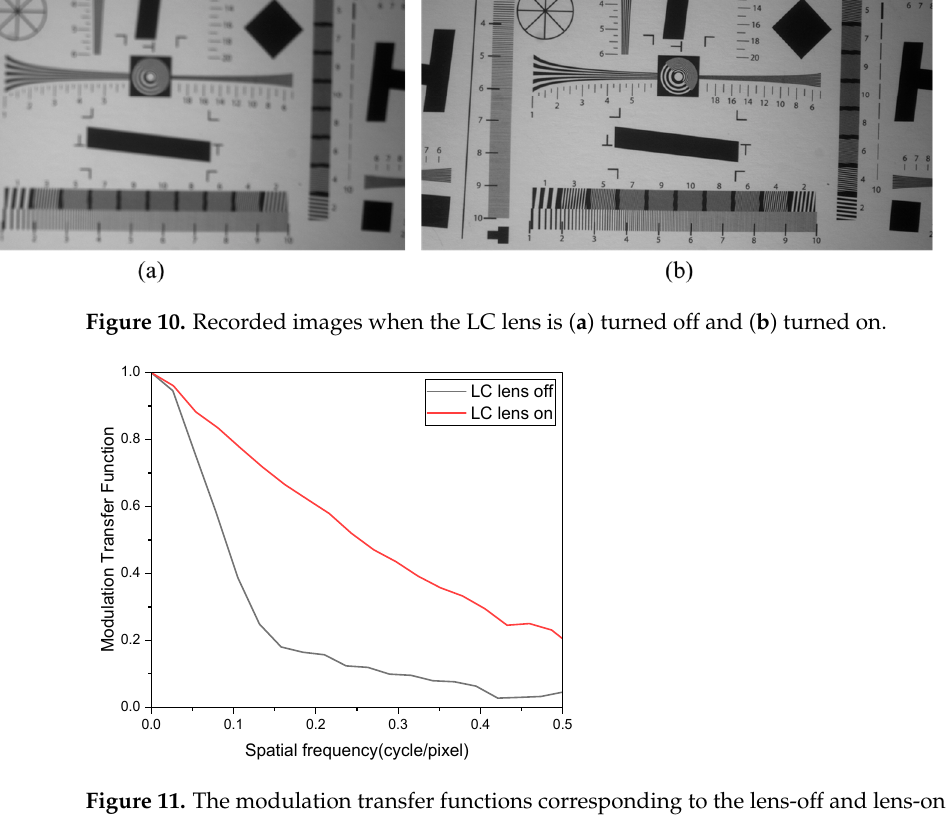
Figure 9. ( a ) Phase profile extracted from interference fringes in Figure 8, ( b ) total RMS error. To test the imaging performance of the LC lens, it is inserted into an imaging system with an ISO 12233 chart placed at approximately 19 cm from the CMOS camera. The LC lens is turned off, and the record image (out of focus) is shown in Figure 10a. Then, the LC lens is turned on ( V 1 = 1.6 V rms , V 2 = 1.9 V rms ), and the image is brought into focus by the positive lens, as shown in Figure 10b. The dimensions of Figure 10a,b are both 2346 × 1623 pixel. The modulation transfer functions (MTFs) are shown in Figure 11. The value of MTF50 is approximately 0.25 when the LC lens is turned on, which confirms the high ‐ quality performance of the LC lens.